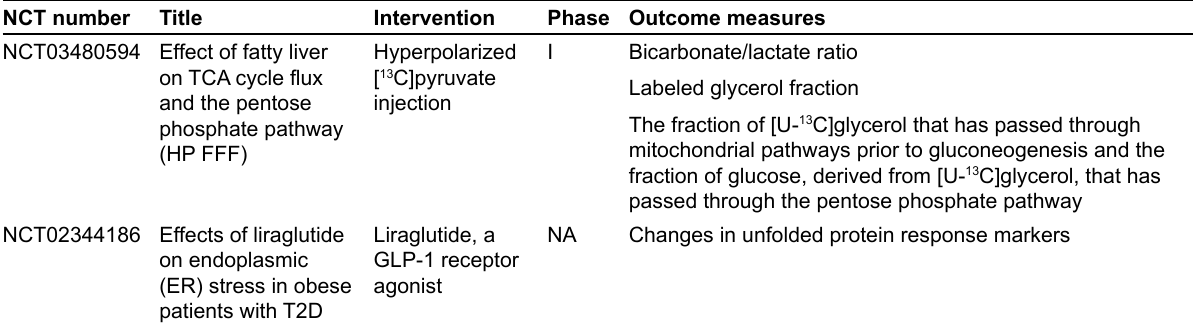
Table 2 . Clinical trials for the intervention of NAFLD ( continued ) NCT number Title Intervention Phase Outcome measures I Bicarbonate/lactate ratio NCT03480594 Effect of fatty liver Hyperpolarized on TCA cycle flux [ 13 C]pyruvate Labeled glycerol fraction injection and the pentose The fraction of [U- 13 C]glycerol that has passed through phosphate pathway mitochondrial pathways prior to gluconeogenesis and the (HP FFF) fraction of glucose, derived from [U- 13 C]glycerol, that has passed through the pentose phosphate pathway NCT02344186 Effects of liraglutide Liraglutide, a Changes in unfolded protein response